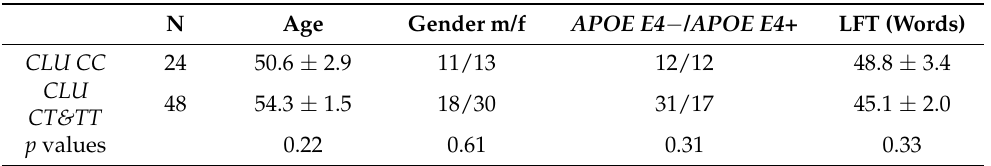
Table 2. Demographic information, APOE genotype, and LFT performance of nondemented individ- uals aged 30 to 80 years with different CLU genotypes.